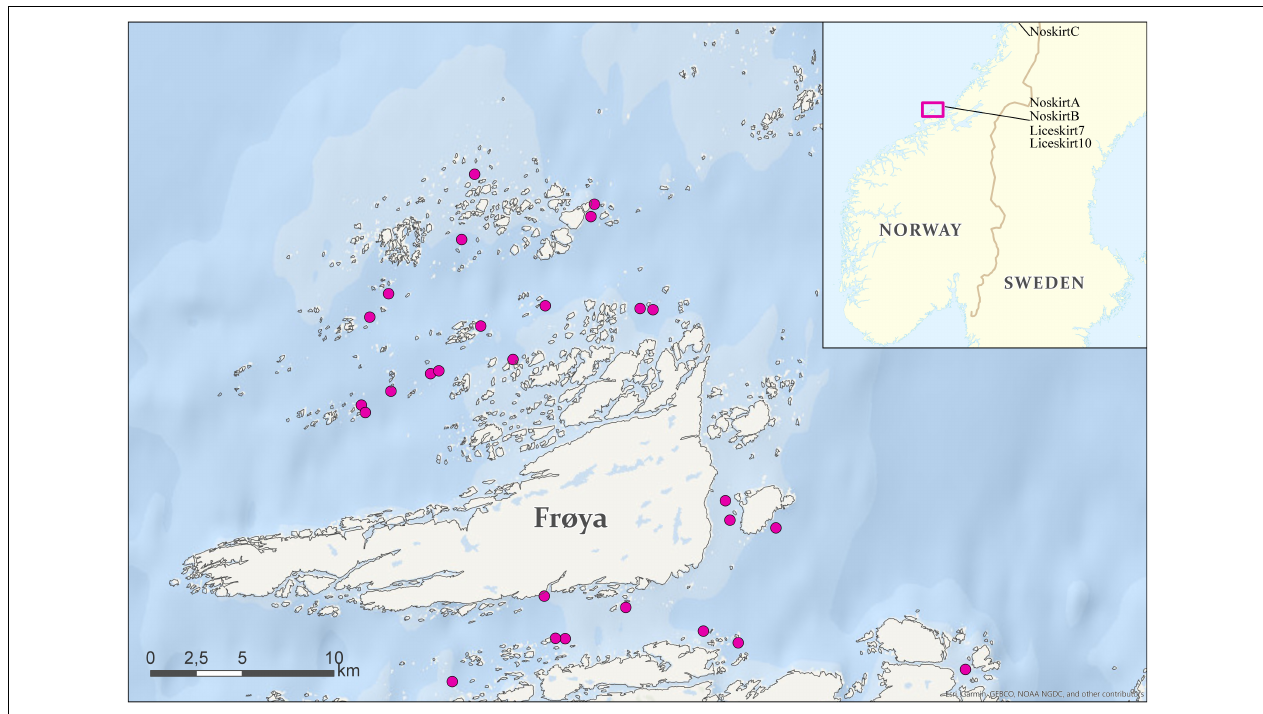
FIGURE 1 | Map over study area. Circles indicate salmon farms. Rough placement of sites is given in the small map. Map created by Tale Skrove. © Kartverket © Europa